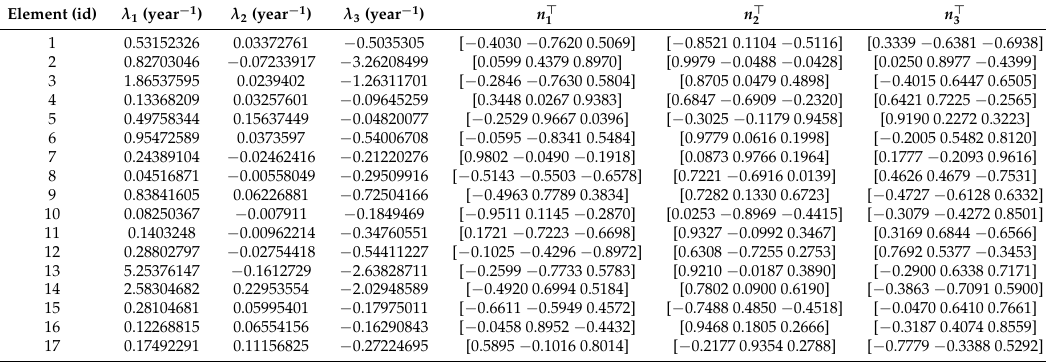
Table 2. Principal strain-rate components. Eigenvalues and eigenvectors of the strain-rate tensor in the year 2003. The extension is denoted by the maximum eigenvalue λ 1 , and contraction is denoted by the minimum eigenvalue λ 3